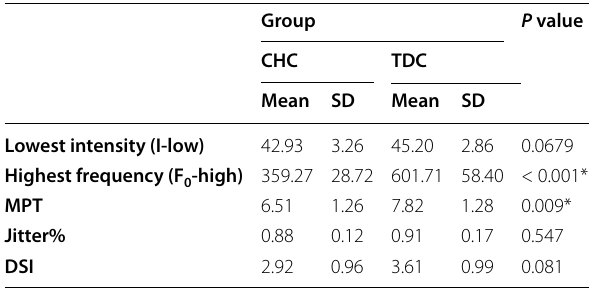
Table 4 Comparison between males and females in typically Table 3 Comparison between congenital hypothyroid children developing children (TDC) for the DSI and its parameters (I-low, (CHC) and typically developing children (TDC) regarding the DSI and its parameters (I-low, F -high, MPT, and jitter %) 0